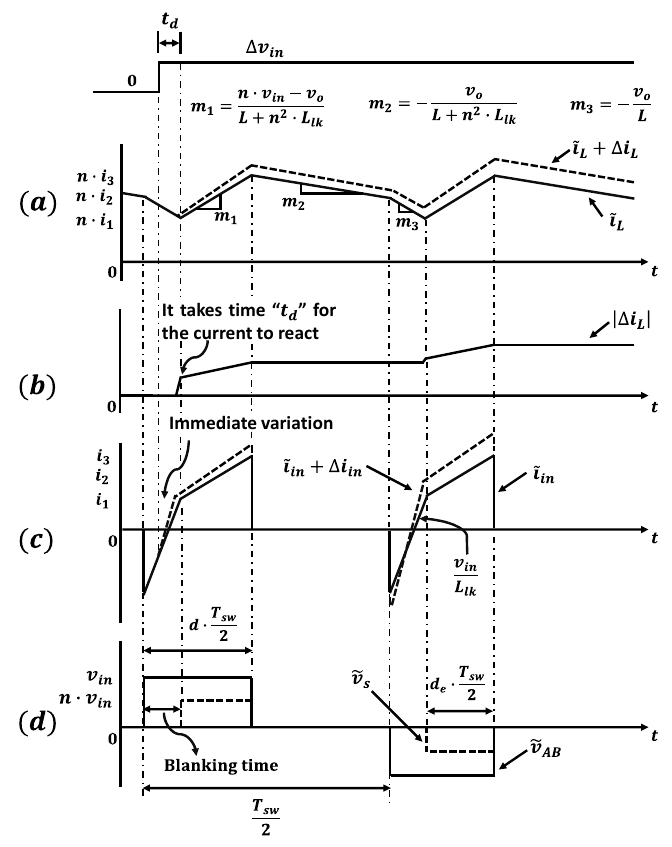
Figure 5. Dynamic response to an input voltage step change. ( a ) Output inductor current, ( b ) incremental component of output inductor current, ( c ) input current and ( d ) primary and secondary voltage.